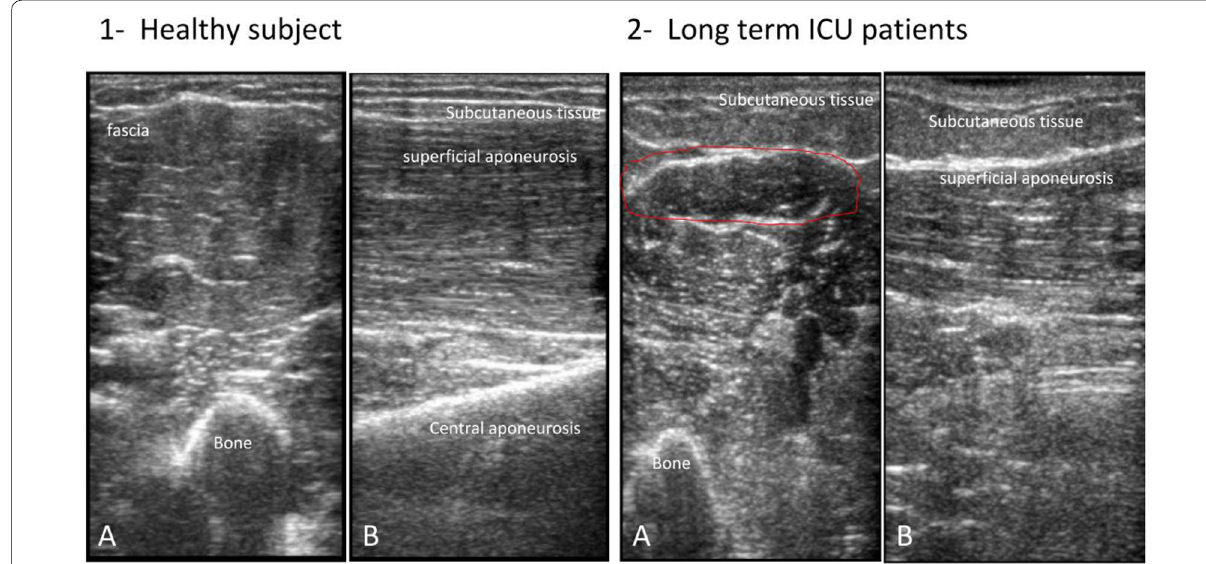
Fig. 1 Ultrasound distinctive appearance of muscle tissue. The figure shows a transverse ( a ) and longitudinal ( b ) ultrasound scan of elbow flexor (bicep brachialis) in healthy (1) and long-term ICU (2) subjects. In the axial image, muscle consists of primarily hyper-echogenic areas scattered with small bright curved echoes of superficially random orientations. In the sagittal plane, these bright echoes are seen to be the fibrous tissue that surrounds muscle fibers and fascicles and which organize into recognizable striations. In bipennate or multi-pennate muscles, a central aponeurosis can be identified as an area of thickened fibrous tissue that when followed distally becomes the tendon. Bone is highly echogenic with a deep shadow beneath the bright hard edge. Subcutaneous fat is typically of similar echogenicity to muscle and is interposed with brighter, poorly organized strips of connective tissue. Near the myotendinous junction, the myofascial fibrils merge, resulting in increased echogenicity and higher anisotropy. In the healthy tissue, the hyper-echogenic muscle is interspersed with bright fibro adipose tissue and the bone reflection is bright and sharply defined; in the long-term ICU patient, the muscle tissue appears as non-homogenous and reduced in its